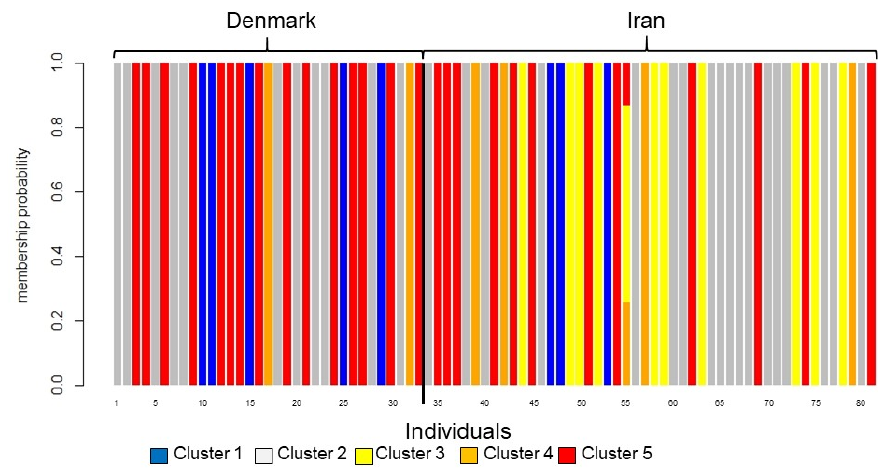
Figure 3. Graphical translation of membership probabilities to the five clusters. The colors of the bars correspond to the clusters in Figure 1. The vertical axis gives membership probability from 0 to 1. All isolates except isolate 55 are assigned with 100% certainty. The black vertical line separates Danish and Iranian isolates. The clusters are almost evenly distributed between Denmark and Iran except cluster 3 (yellow), which is only found in Iran.